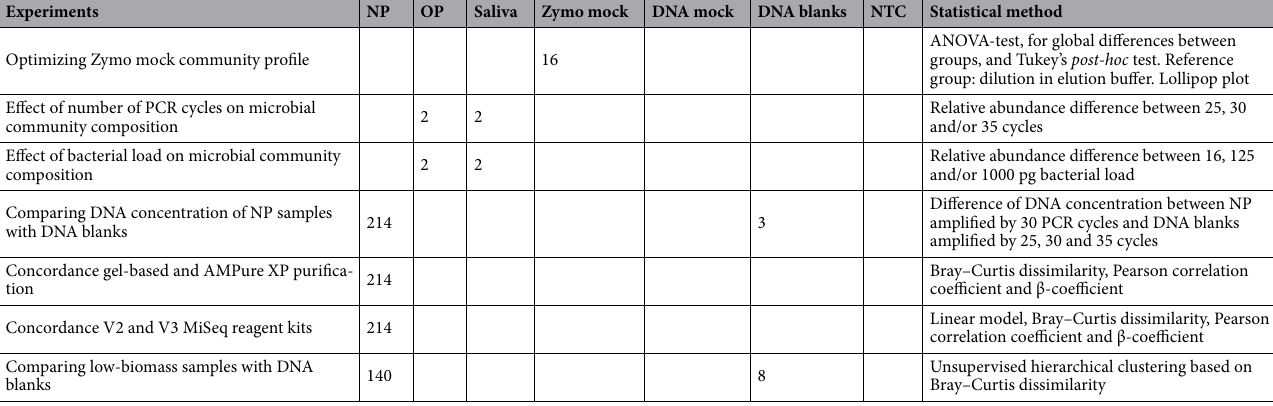
Table 1. Samples and statistical method per experiment. NP = Nasopharynx, OP =